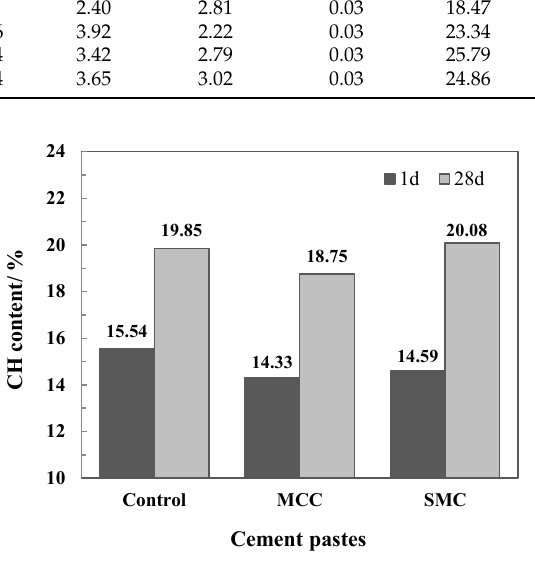
Figure 8. CH content in cement pastes at the age of 1 and 28 days.